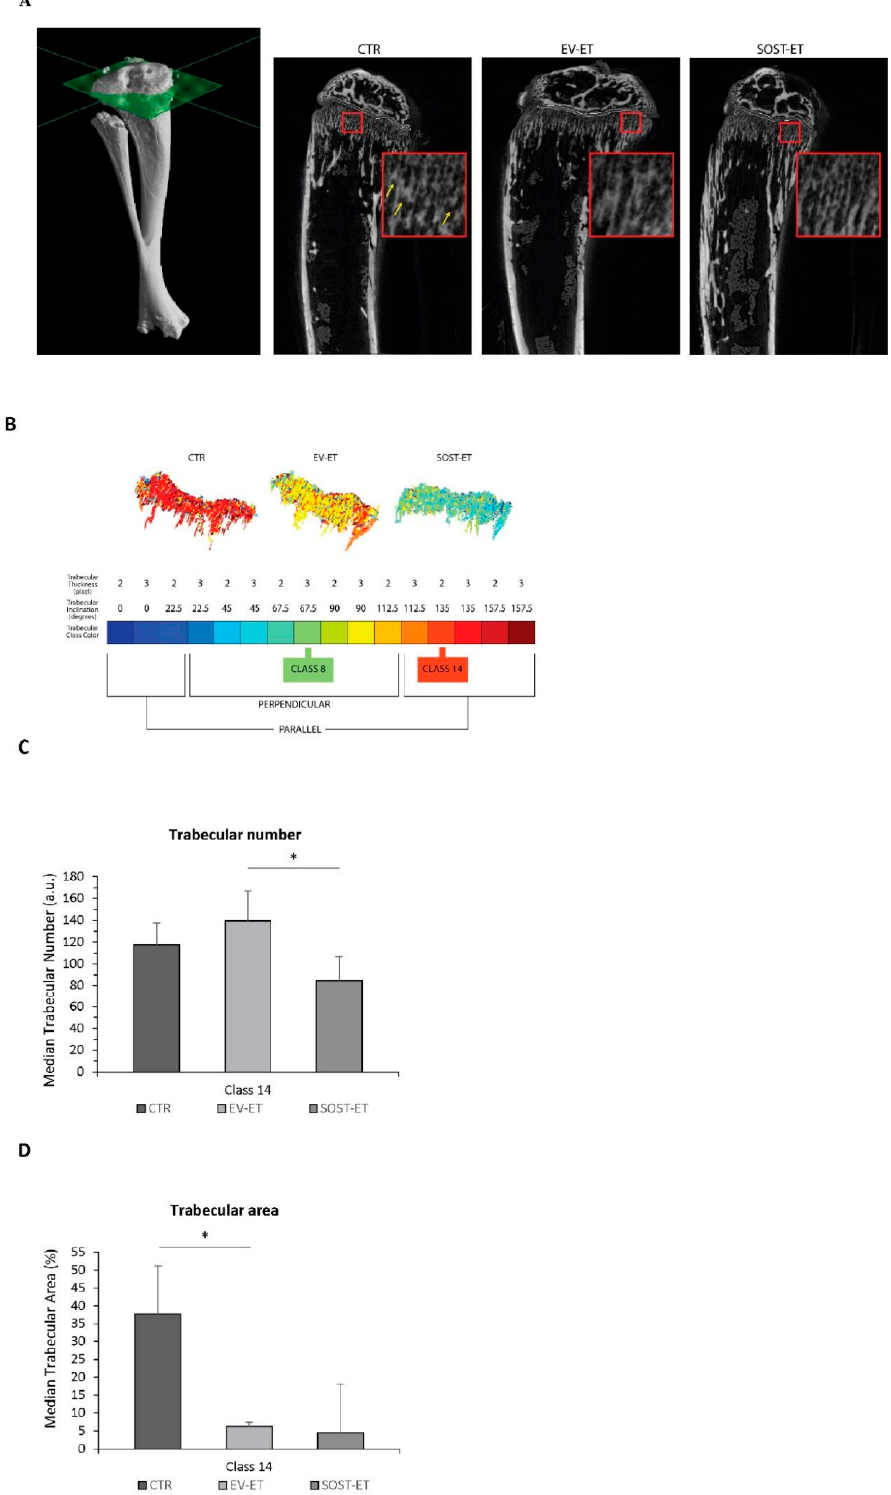
Figure 7. ( A ) Exemplificative µ CT scans of the metaphyseal plate for each group of animals: CTR, EV-ET, and SOST-ET. Yellow arrows show the trabecular orientation. ( B ) Heat maps that represent the space occupied by the various classes with a color code. Legend of the major represented trabecular classes. Class 8 (yellow, green) is representative of perpendicular trabeculae and Class 14 (red) is representative of parallel trabeculae. ( C , D ) Variation in median values of the trabecular number and trabecular area for trabeculae of class 14 ( ± median absolute deviation (MAD) of trabeculae for classes (typology)). Asterisk (*) indicates significant comparisons, p < 0.05 according to the Wilcoxon–Mann–Whitney test with the Bonferroni